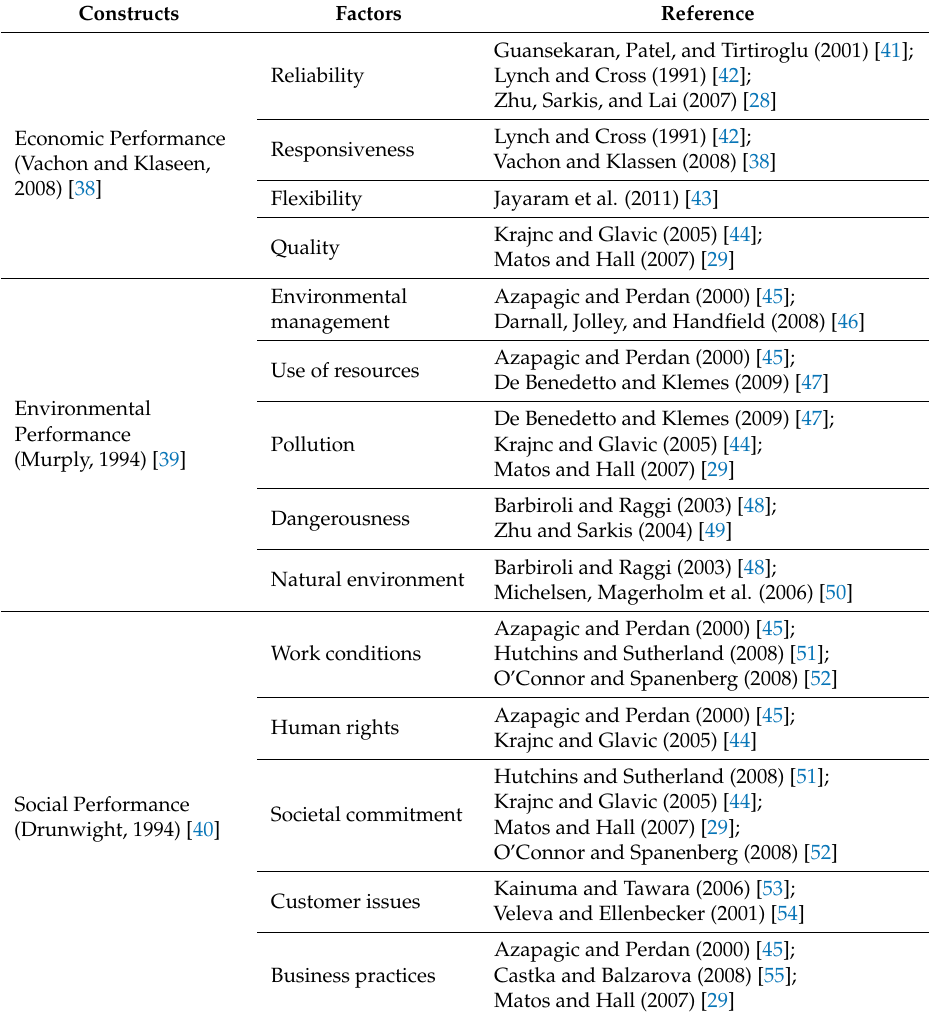
Table 2. Economic performance, environmental performance, and social